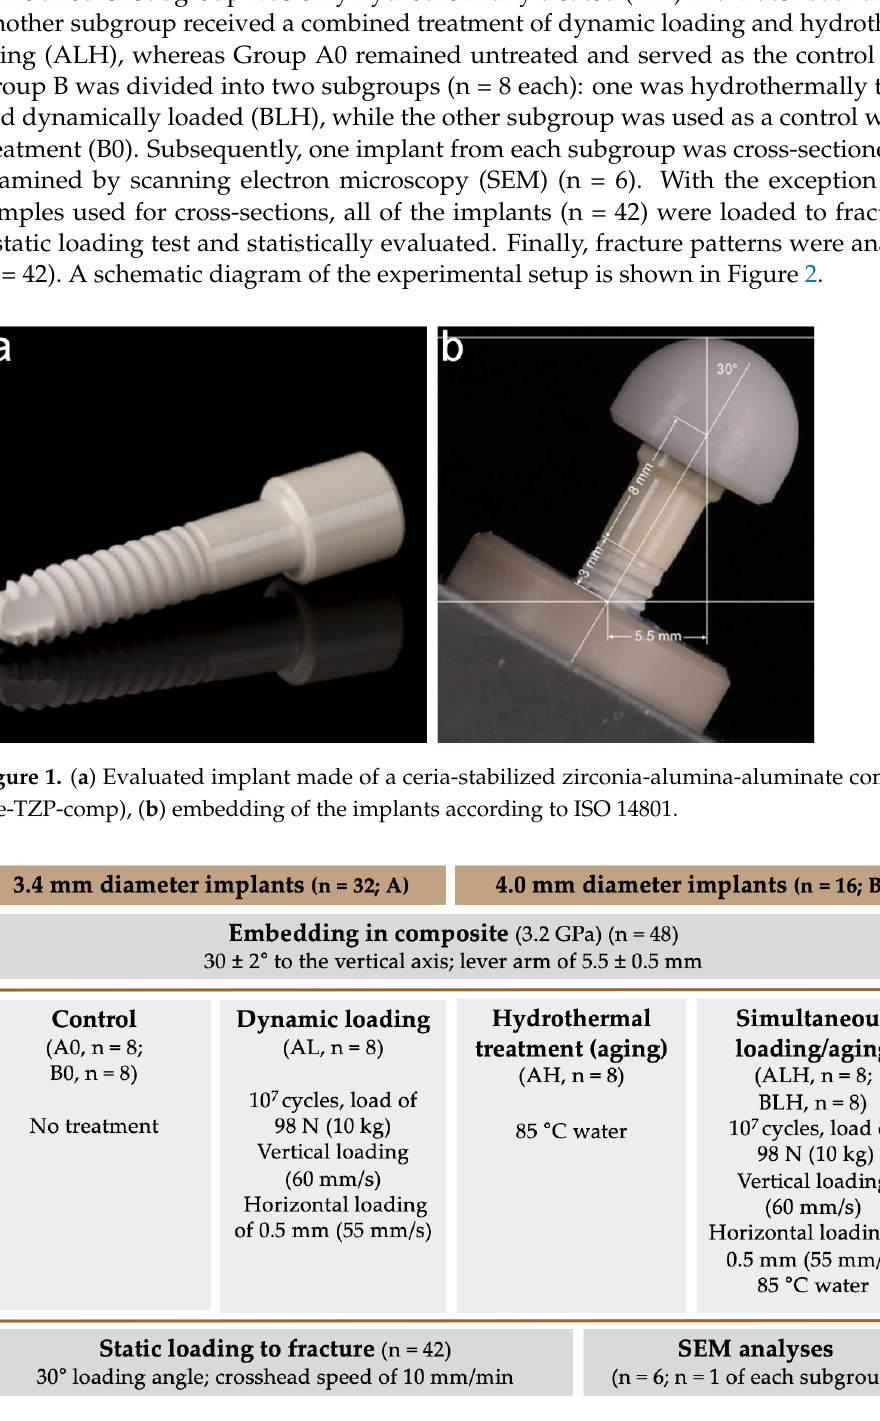
Figure 2. Schematic diagram of the experimental setup.